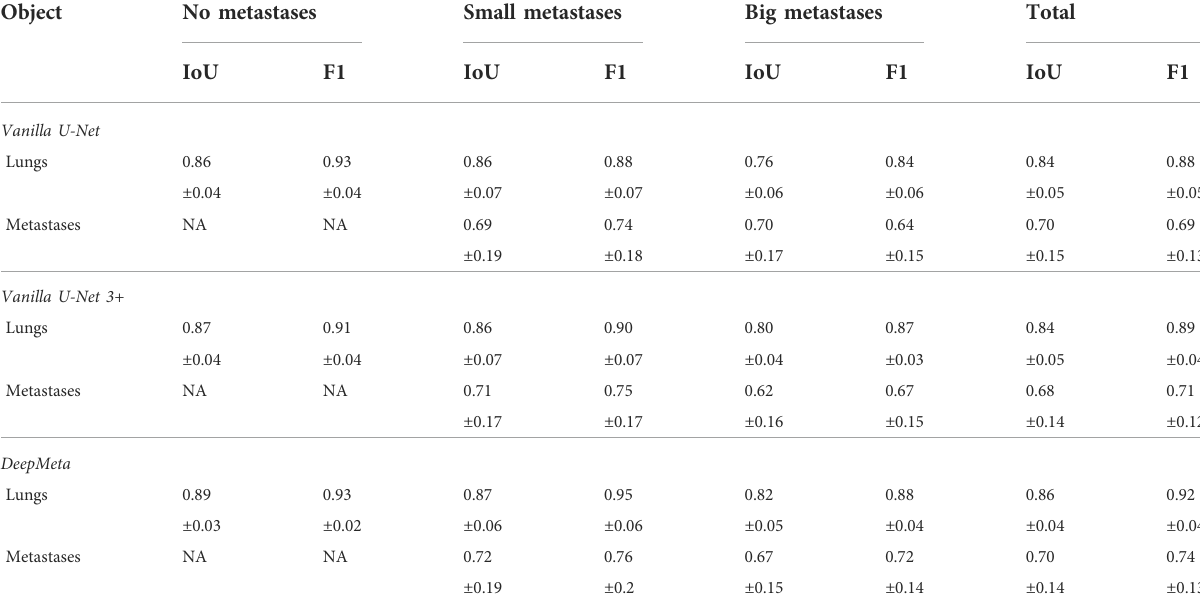
TABLE 2 Models performance are measured by IoU and F1-score for both lungs and metastases segmentation in our representative test set for DeepMeta, vanilla U-Net and vanilla U-Net 3+ architectures. This set includes mice without metastases and having either small or large metastases. The last column shows the mean values across the entire test